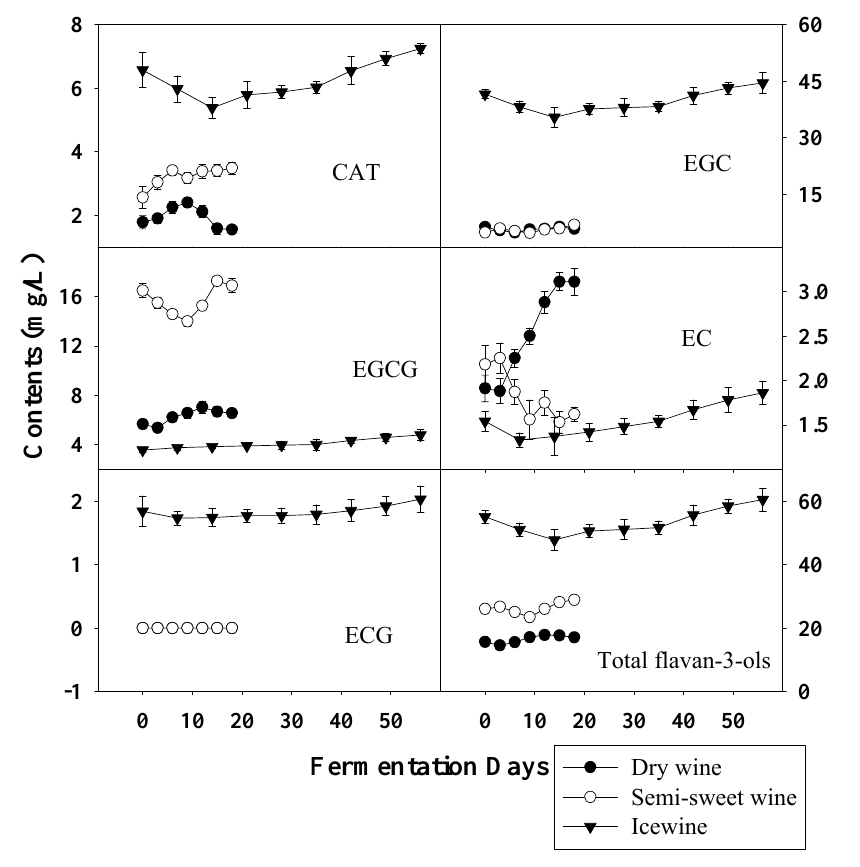
Figure 7. Evolution of flavan-3-ols during the fermentation of dry wine, semi-sweet wine and